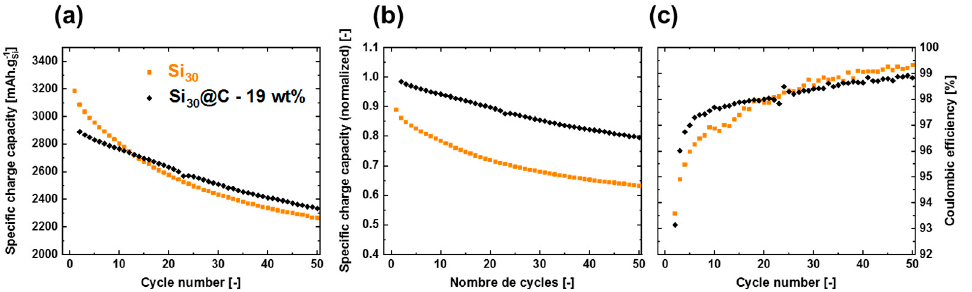
Figure 3. ( a ) Galvanostatic cycling results of both studied materials Si 30 and Si 30 @C—19 wt% over the first 50 cycles ( b ) normalized galvanostatic results for the same materials. The specific capacity at each cycle is divided by the charge capacity at the first cycle, taking into account the specific capacity of carbon at 150 mAh·g − 1 . ( c ) Coulombic efficiency for the same materials.